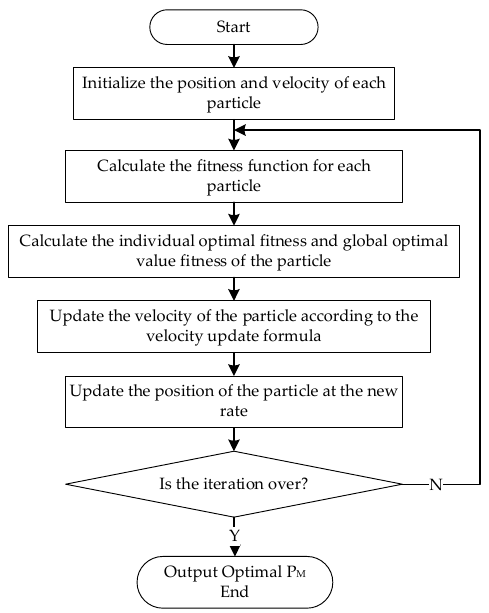
Figure 4. Flowchart of PSO algorithm.